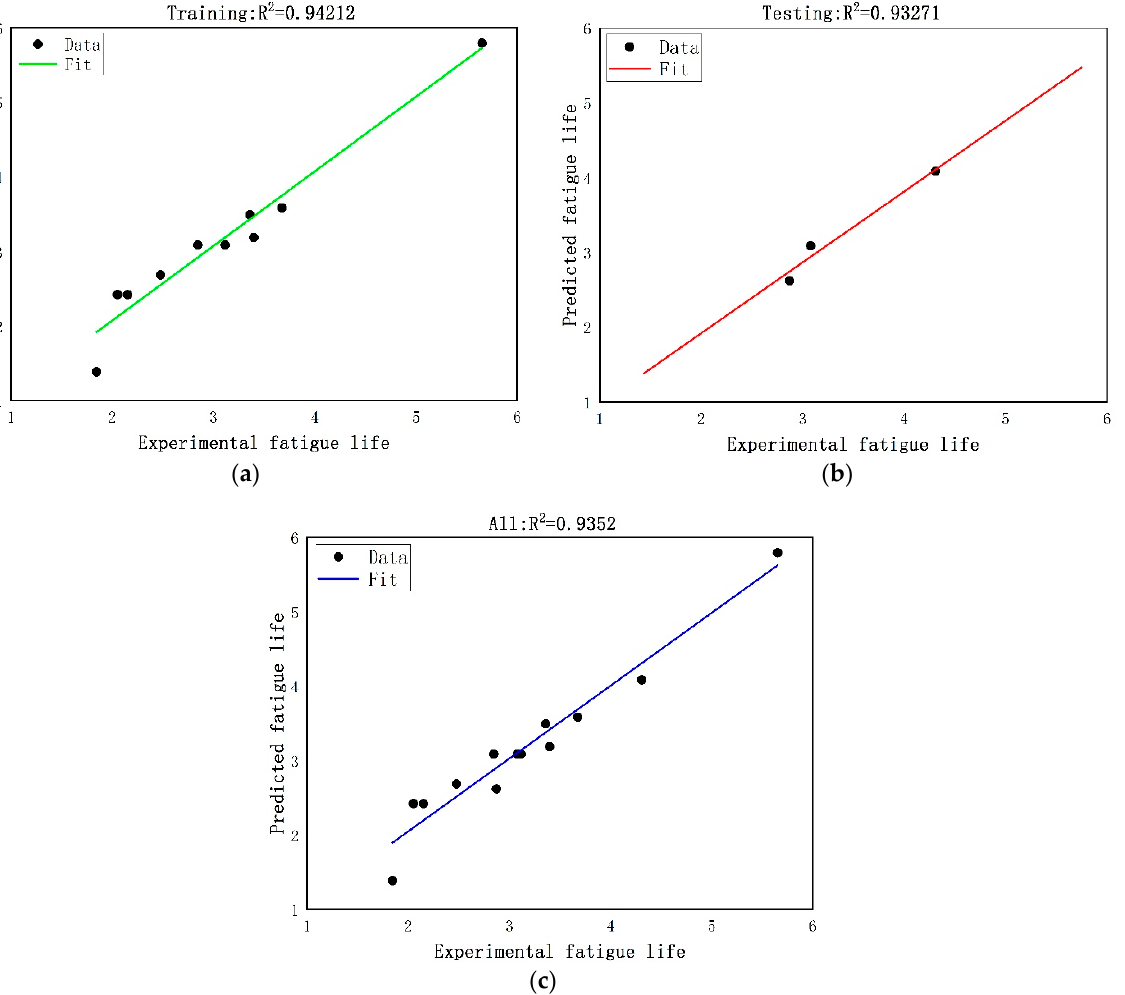
Figure 5. The regression plots for the model predicting fatigue life. ( a ) Training data. ( b ) Testing data. ( c ) All data.